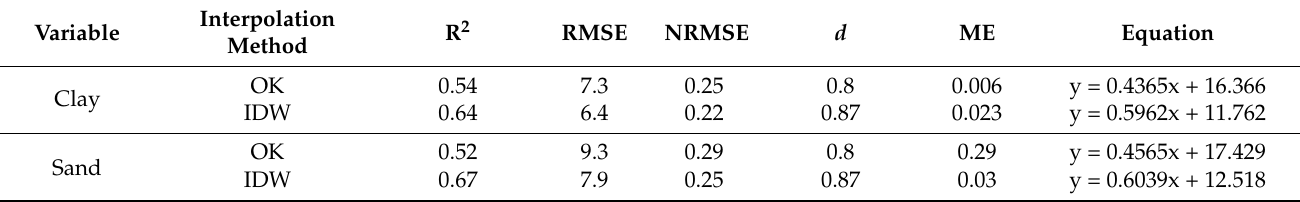
Figure 5. Scatter plots and best fit lines of linear regression between observed and predicted soil particle content according to identity line (gray dotted) and linear regression models. C: clay content; OK: ordinary kriging; S: sand content; IDW: inverse weighted distance. Table 5. Statistics validation of sand and clay particles interpolation.